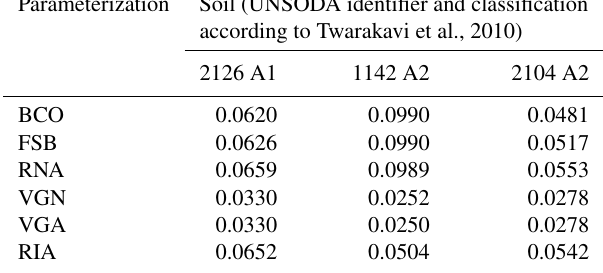
Table C5. Root mean square errors of the parameter fits for the sandy or loamy soils (A1 and A2 soils, according to Twarakavi et al.,